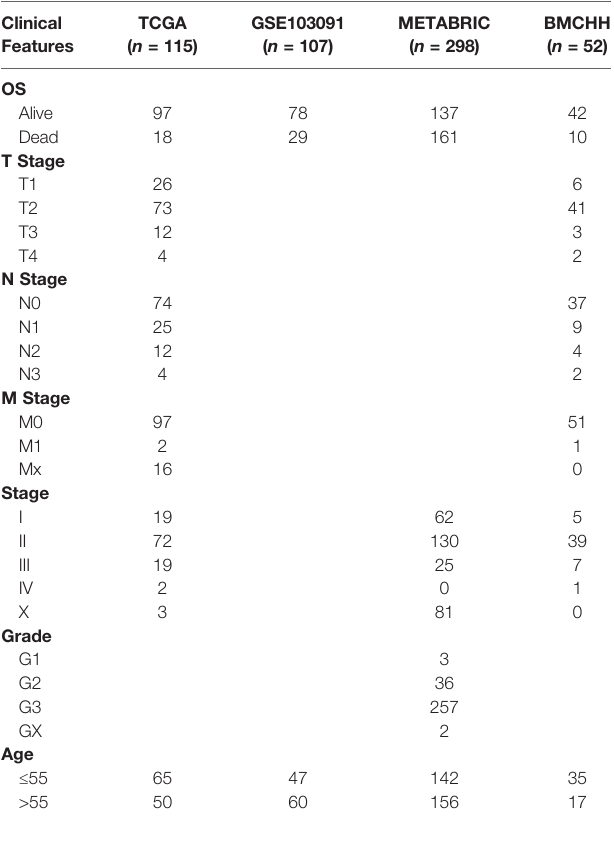
TABLE 2 | Demographics and clinicopathological features of patients in the TCGA, GSE103091, METABRIC, and BMCHH cohort. Clinical